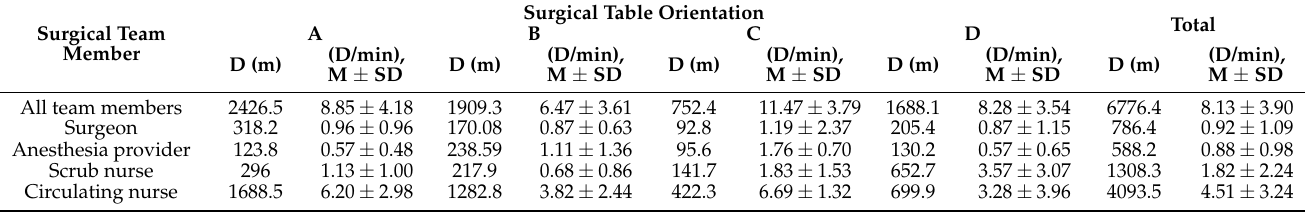
Surgical Table Orientation